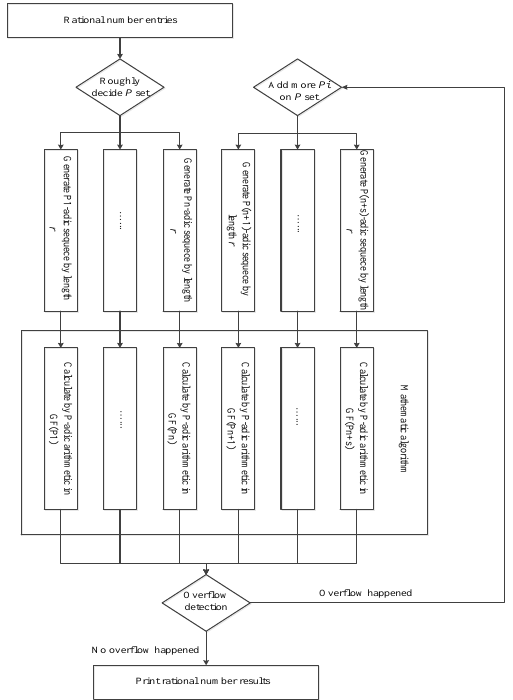
Fig. 6. Multiple P-adic arithmetic implementation flow